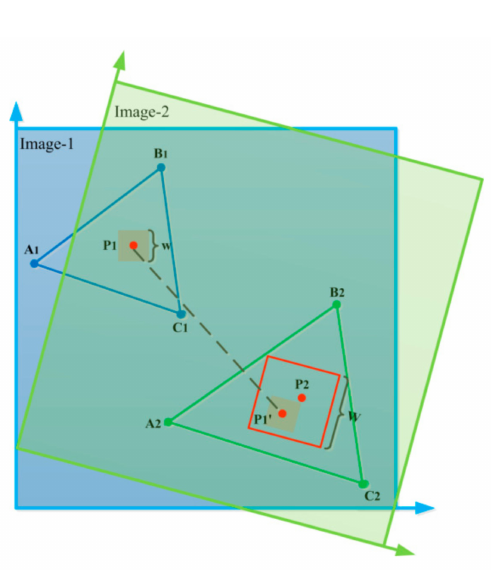
Figure 5. Combination of feature tracking and pattern matching algorithm.